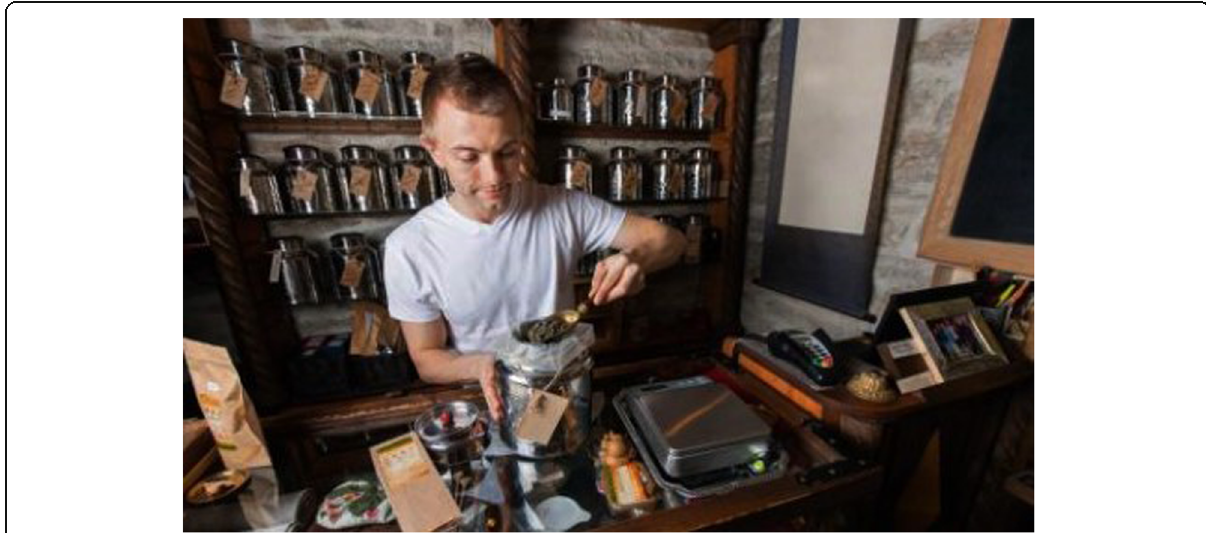
Fig. 3 Salesman decoded frame 23 (PSNR = 36.33